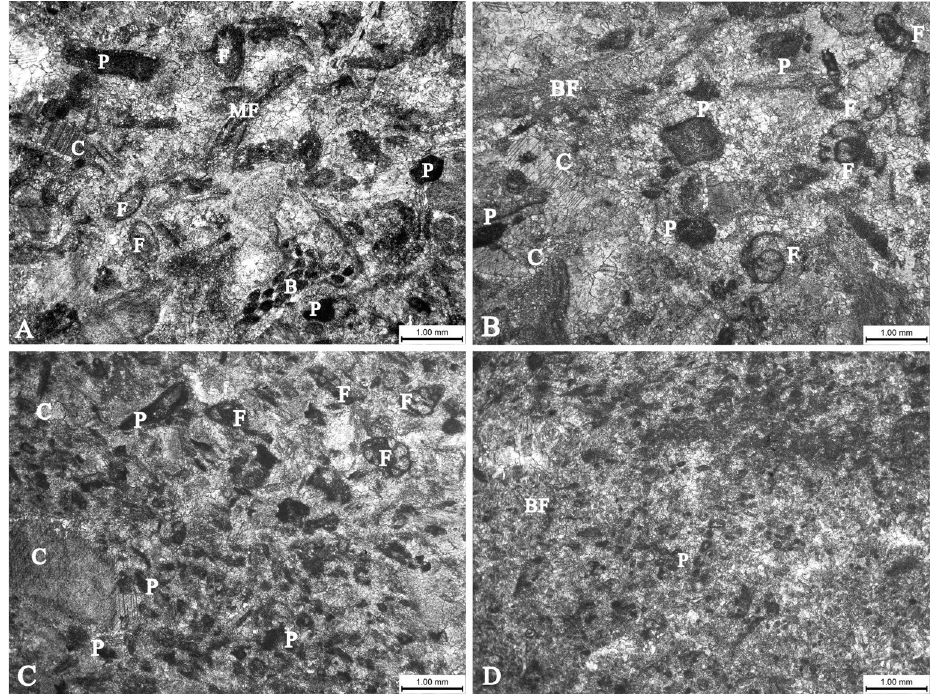
Figure 6. Micrographs of sediments in different positions of reef. ( A ) Calcareous bioclastic limestone, with biological particles accounting for about 70% of the debris. Abundant and diverse organisms indicate a medium-energy environment of the subtidal zone. Samples were taken from the bioclastic beach at the reef base. ( B ) Slightly larger bioclastics but lower biologic content than that in ( A ) suggest an increasing water energy. ( C ) Various bioclastic particles account for about 80% of the clastic particles contained in the calcareous bio- granular rock. The obviously small benthos indicate a low-energy environment in the subtidal zone barriered by the Diphyphyllum clusters. ( D ) Bioclastic grainstone is mainly composed of marl, with fine clastic particles (about 30%) and bedding. Low biomass indicates a low-energy environment of the subtidal zone. This figure is modified by the author with CorelDRAW (version 2022, and the URL link: https:// www. corel draw. com/ cn/). Meaning of the letters in the figure: C crinoids, BF brachiopods, F foraminifera, B bryozoan, P pelletoid, MF mollusk shell